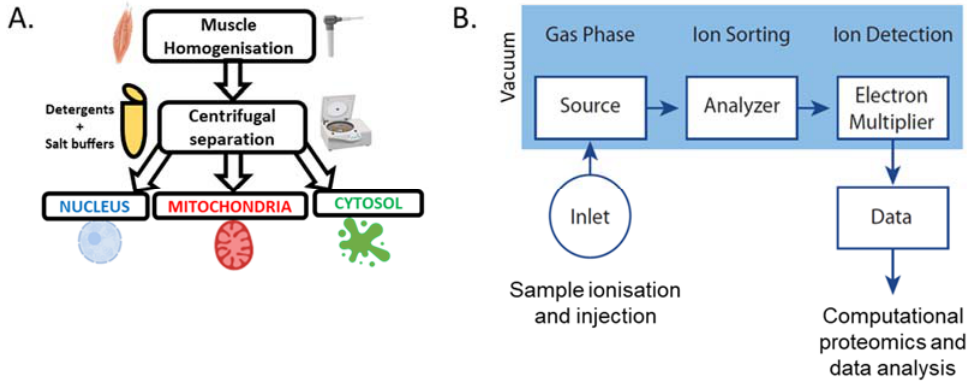
Figure 5. ( A ) Basic methodology for the subcellular fractionation of skeletal muscle [38–40]. ( B ) Basic overview of mass spectrometry workflow [45].